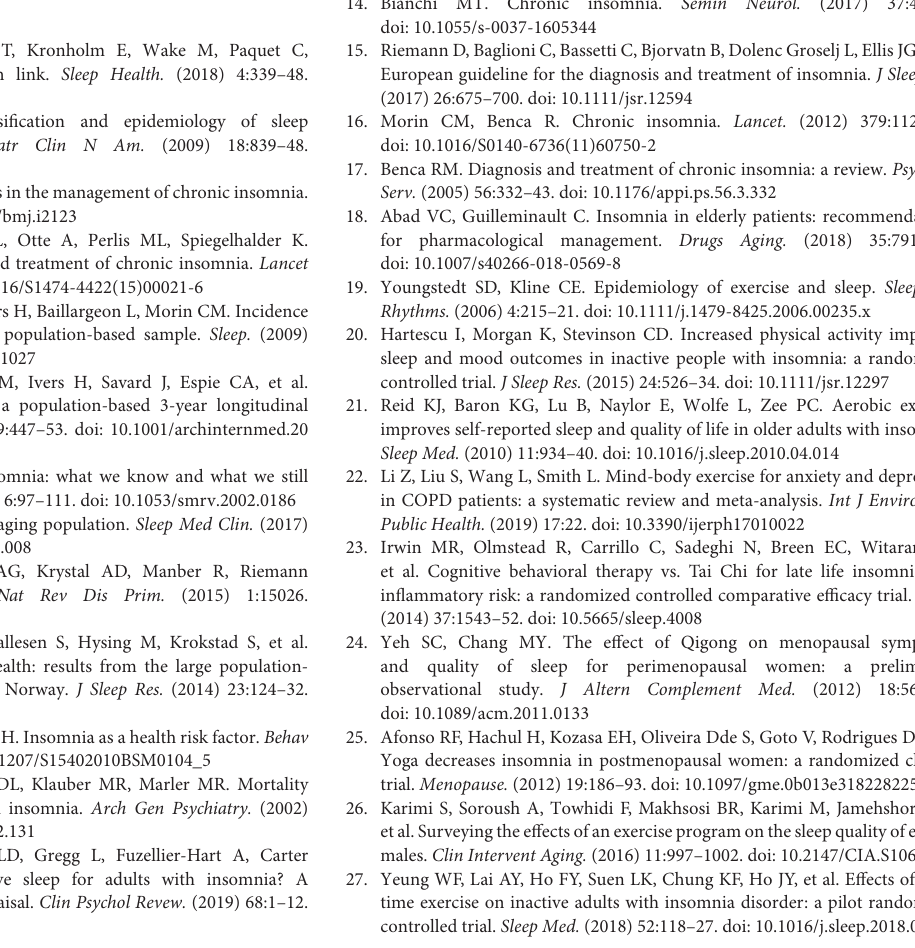
Supplementary Figure 1 | Risk of bias summary. Supplementary Figure 2 | Risk of bias assessments: –, low risk of bias; + , high risk of bias; ?, unclear risk of